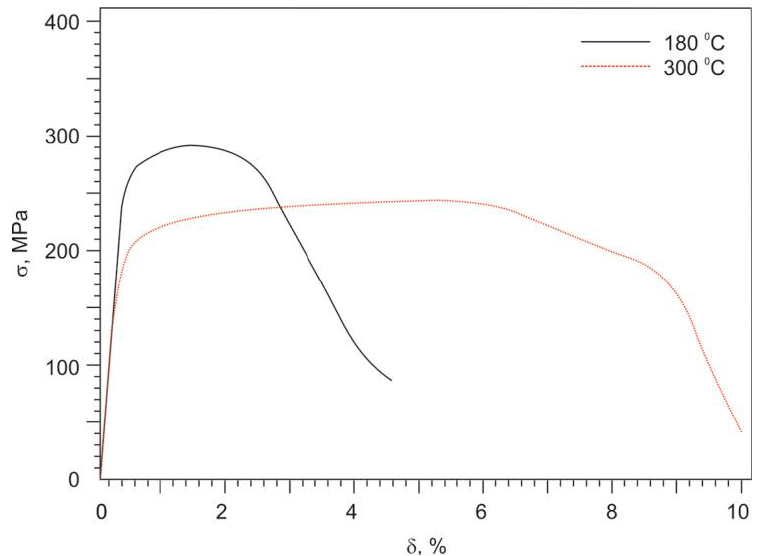
Figure 12. Stress – strain curves for composite sample after rotary forging to a diameter of 5 mm ( e = Figure 12. Stress–strain curves for composite sample after rotary forging to a diameter of 5 mm 2.77) and subsequent annealing at different temperatures. ( e = 2.77) and subsequent annealing at different temperatures.